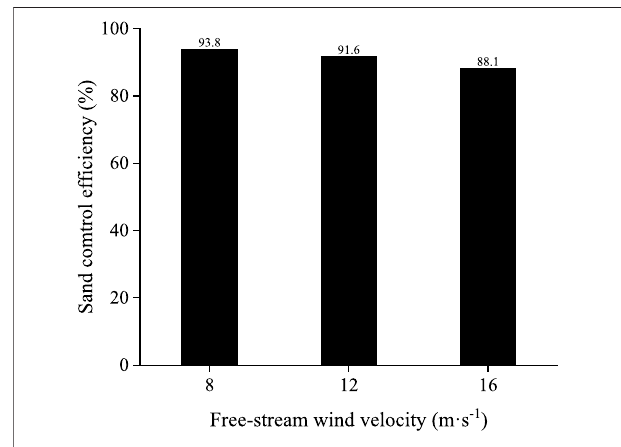
FIGURE 15 | Changes of sand fl ux density at 10H 2 after three rows of windbreak forest belts under different incoming wind velocities.